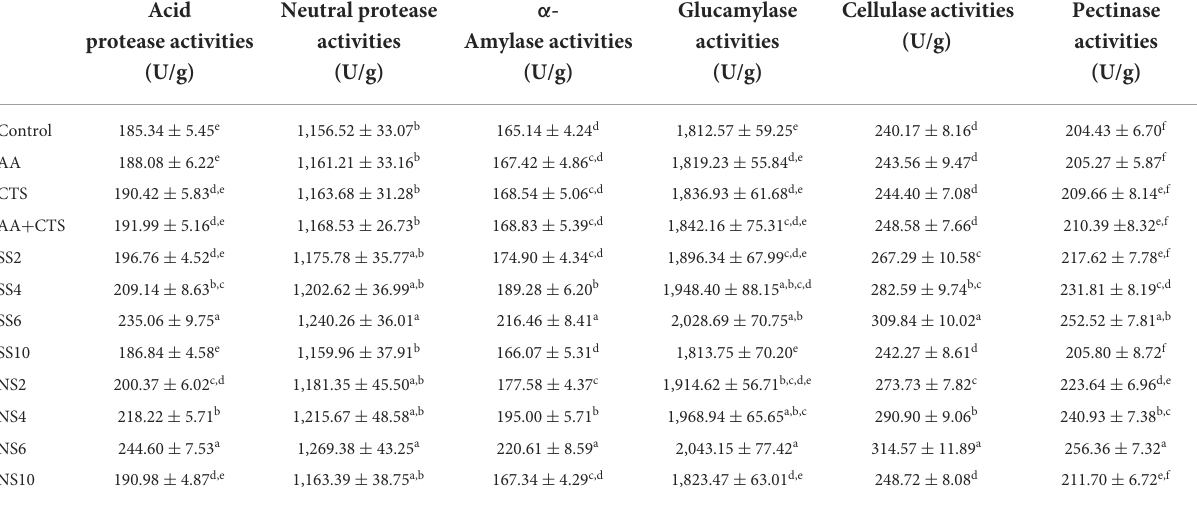
TABLE 5 Effects of selenium on enzyme activities in